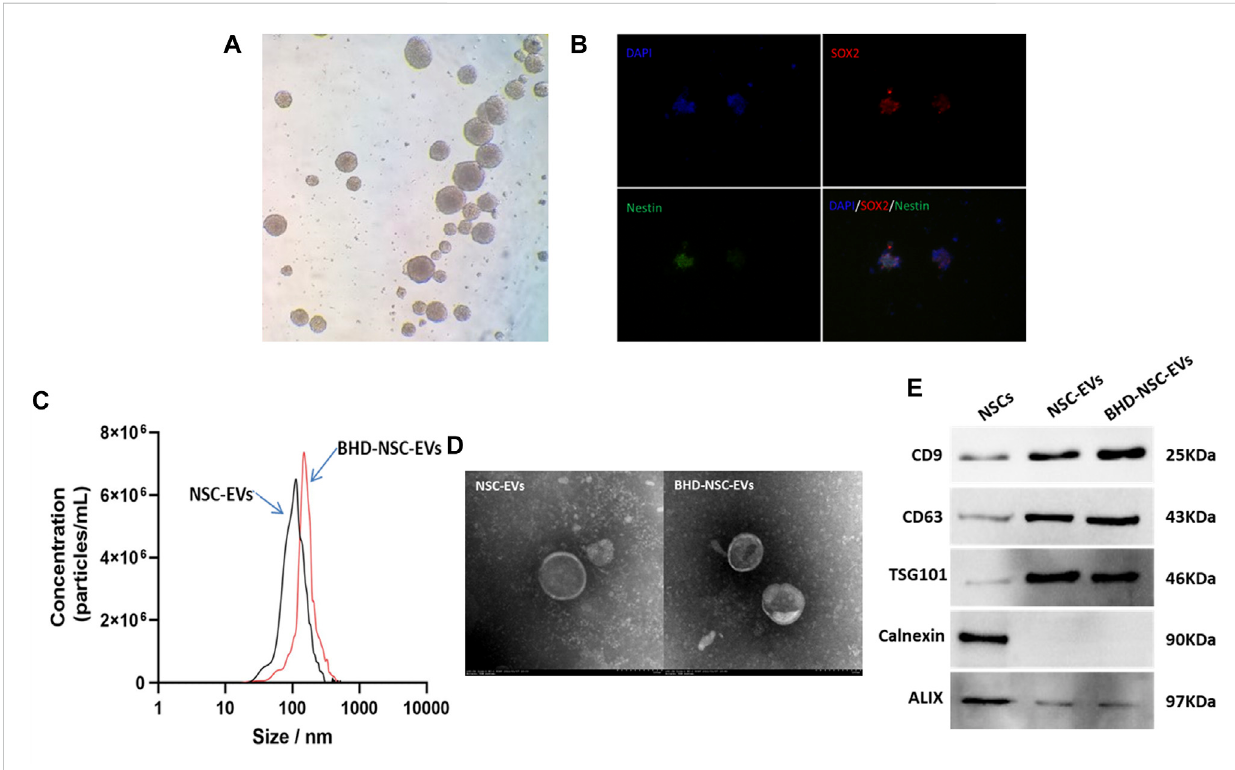
FIGURE 1 Identi fi cation of primary neural stem cell and extracellular vesicles. (A) NSCs were visualized and grew in sphere-like cell clusters under ordinary optics microscope. (B) Immuno fl uorescence staining of adherent neurospheres showed expression of the NSC markers nestin (red) and SOX2 (green) under fl uorescence microscope. (C) Particle size distribution were analyzed by nanoparticle tracking analysis (NTA), which indicated NSC-EVs and BHD- NSC-EVs were different particle size slightly. (D) Transmission electron microscopy (TEM) images revealed small lipid bilayer membrane vesicles morphology of BHD-NSC-EVs scale bar: 100 nm. (E) Western blot analysis was conducted to detect the expression of speci fi c extracellular vesicle- related positive markers (CD63, CD9, TSG101) and negative markers (Calnexin, ALIX) in BHD-NSC-EVs and NSCs. NSC-EVs, Neural Stem Cells